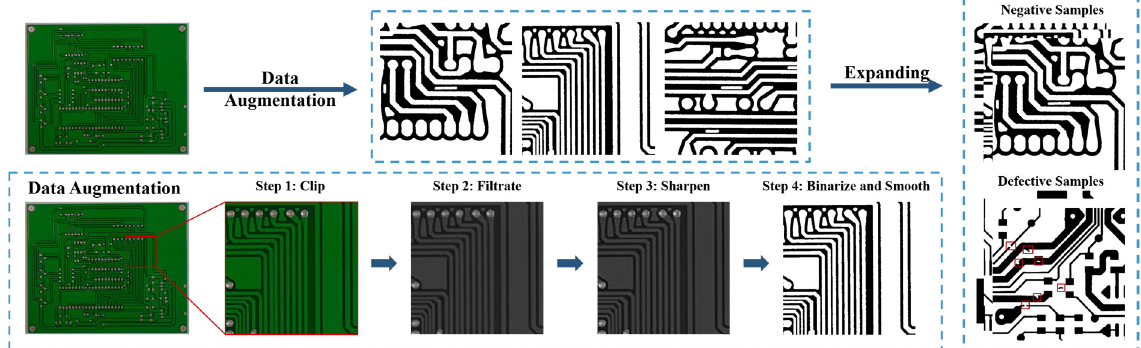
Figure 7. Whole process of proposed data-expanding strategy.